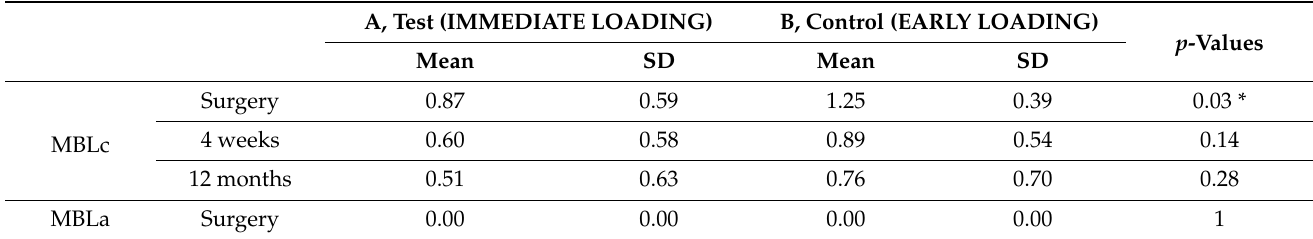
Table 3. Radiographic variables. * p ≤ 0.05. Marginal bone level at the crest (MBLc). Marginal bone level at the abutment (MBLa).